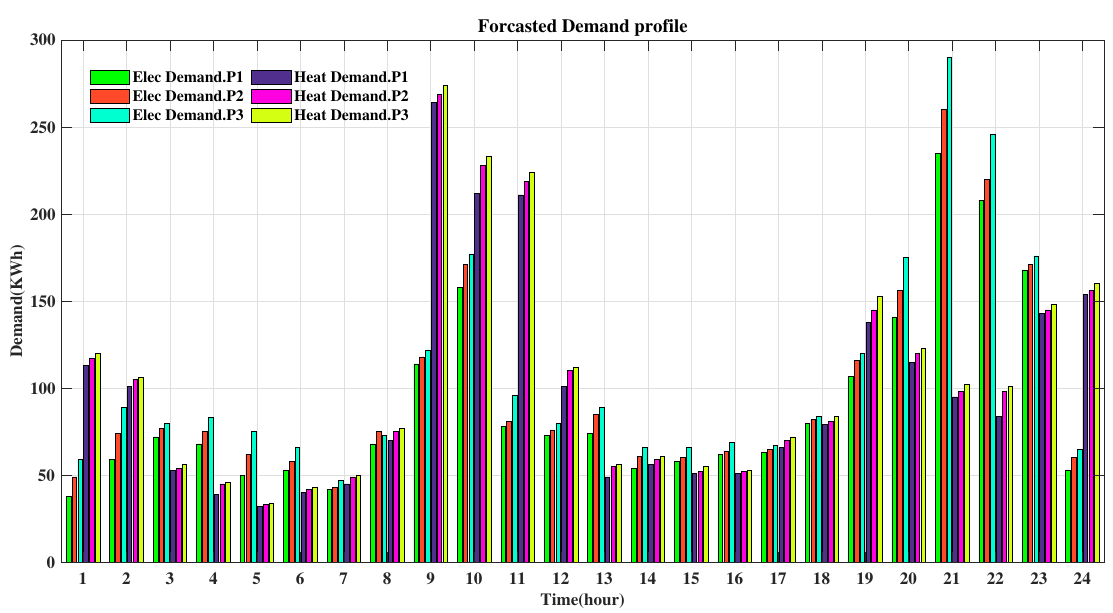
Figure 3. The predicted electrical and thermal demand of each